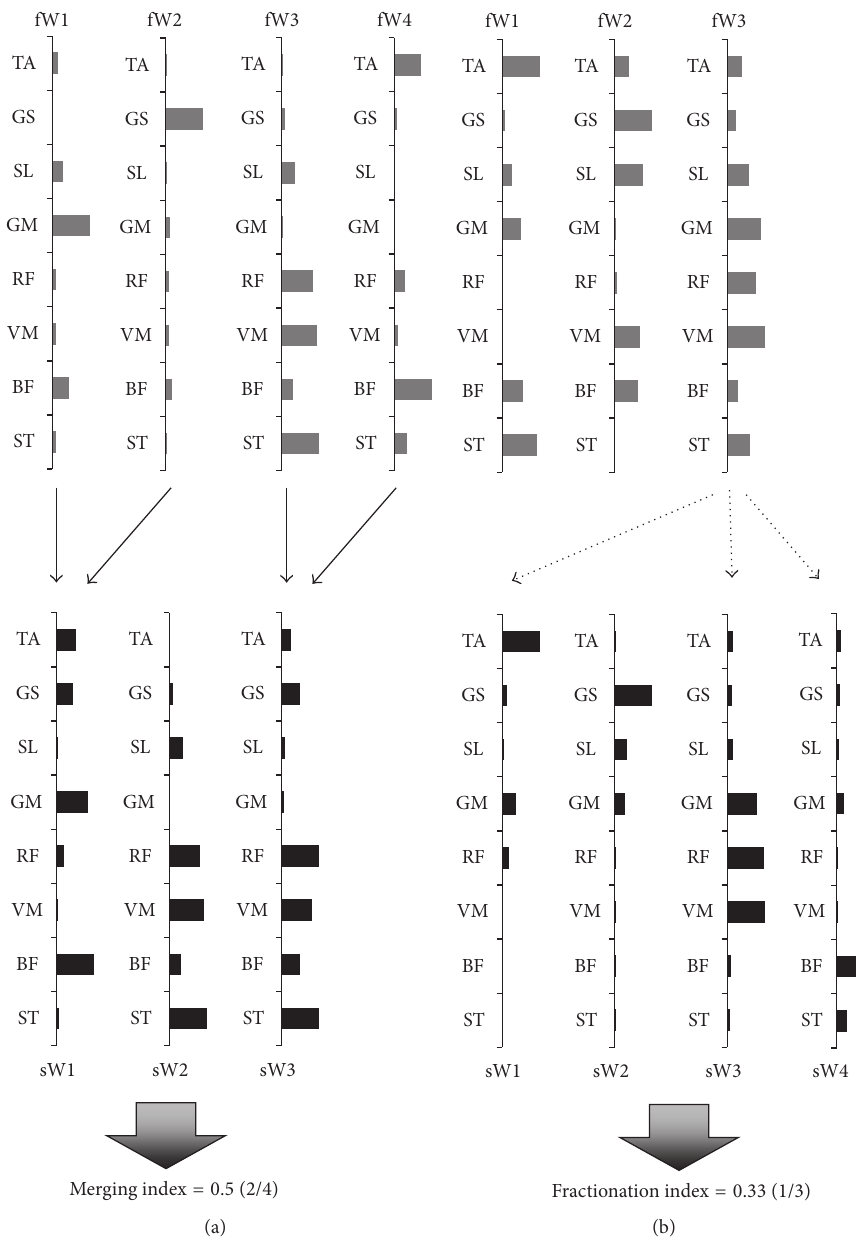
Figure 1: Merging and fractionation of the synergies. The figures show the merging (solid line) and fractionation (dotted line) of the synergies at the first (gray) and second measurements (black). (a) Merging of synergies recorded from a patient; the weighting of the sW2 and sW3 synergy was reconstructed by linearly combining two pairs of synergies (fW1 and fW2, fW3 and fW4) from the first measurement. (b) Fractionation of the synergies that were recorded; the weighting of the fW3 synergy at the first measurement was reconstructed by linearly combining three synergies (sW1, sW3, and sW4) from the second